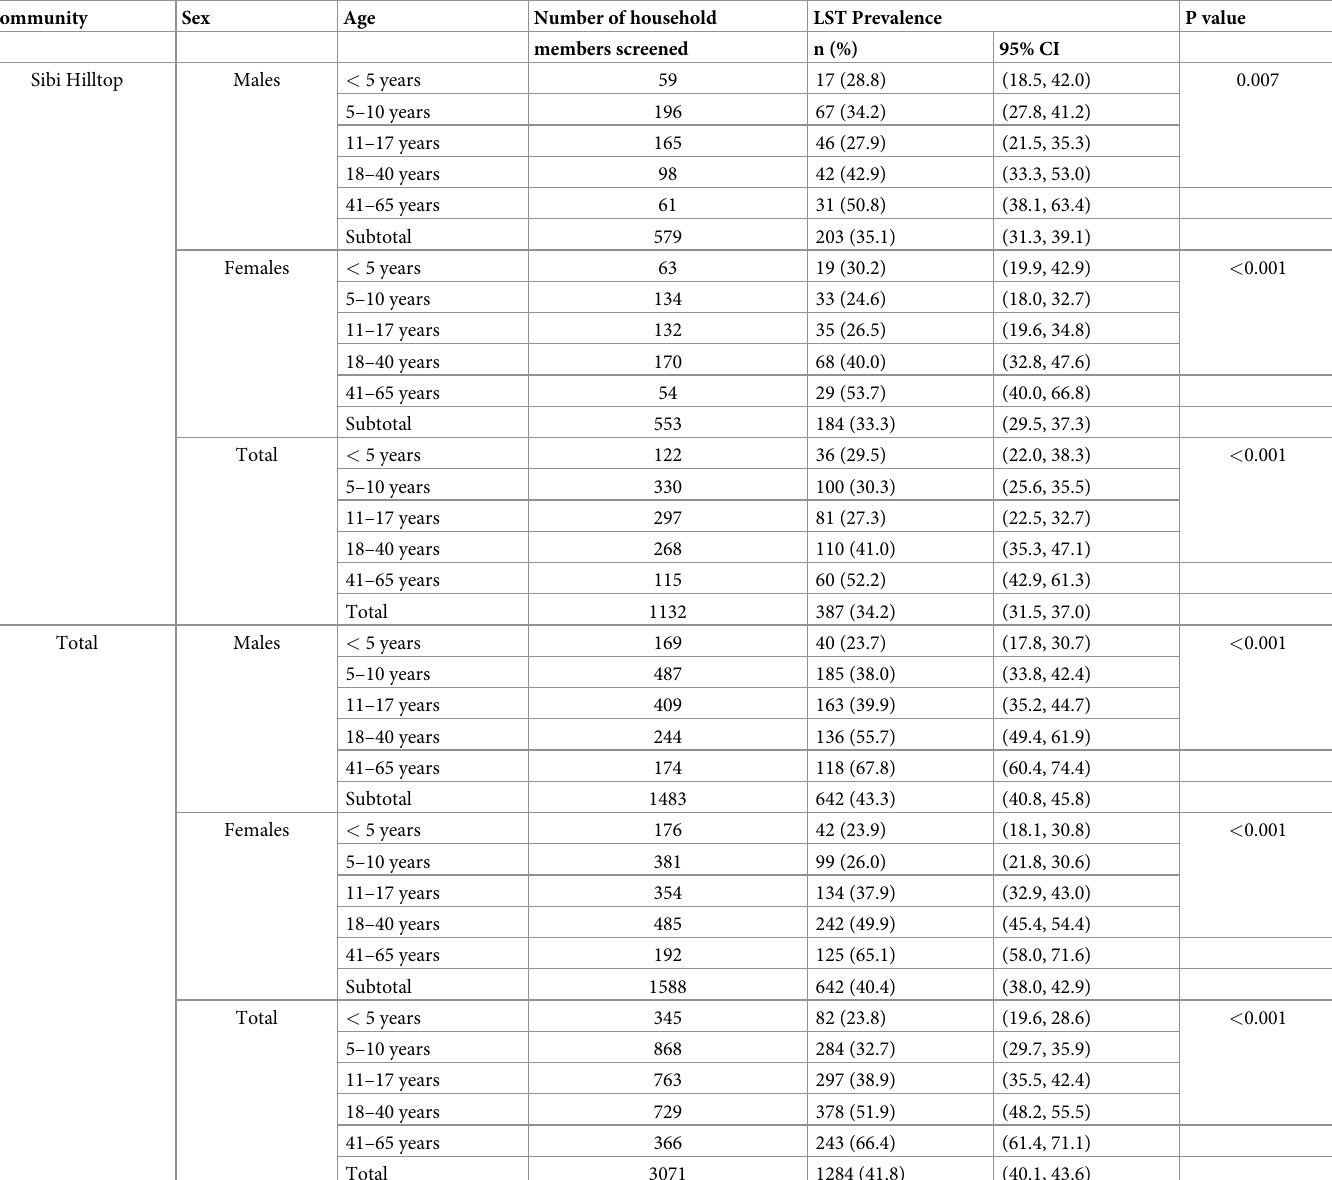
Table 3. LST prevalence by age and sex at Sibi Hilltop and cumulatively for all study sites.